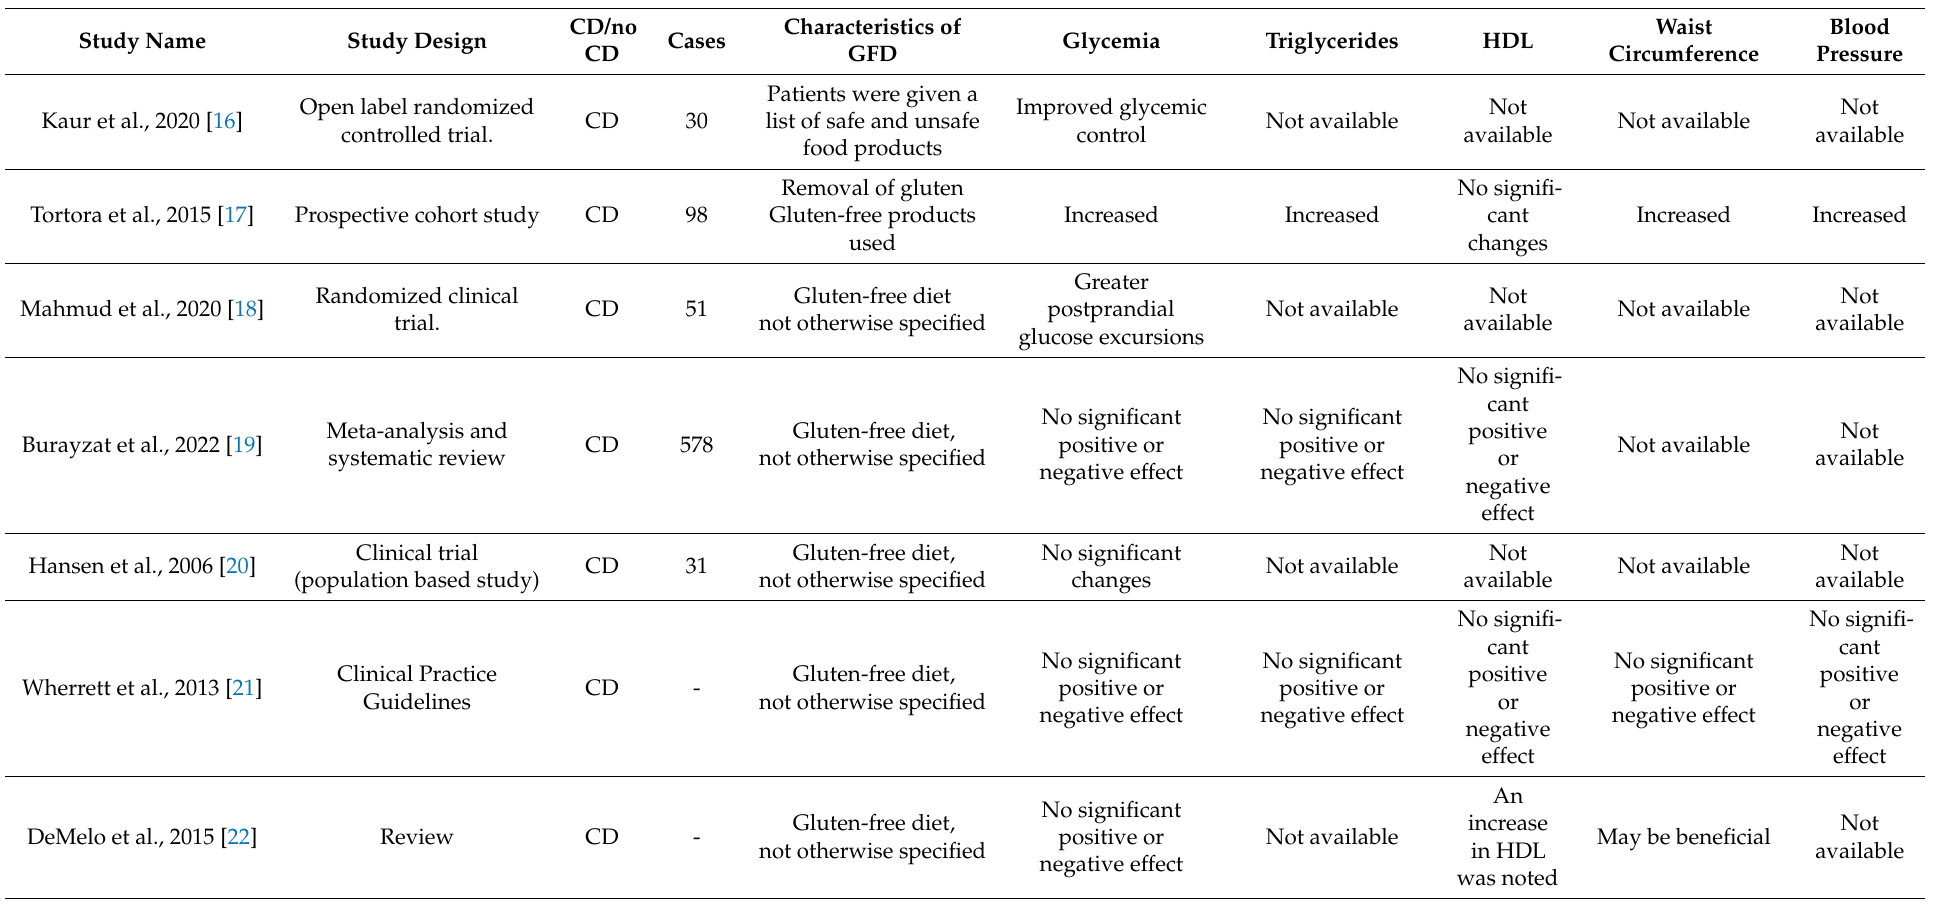
Table 1. Summary of effects of GFD on components of metabolic syndrome in studies on subjects with and without celiac